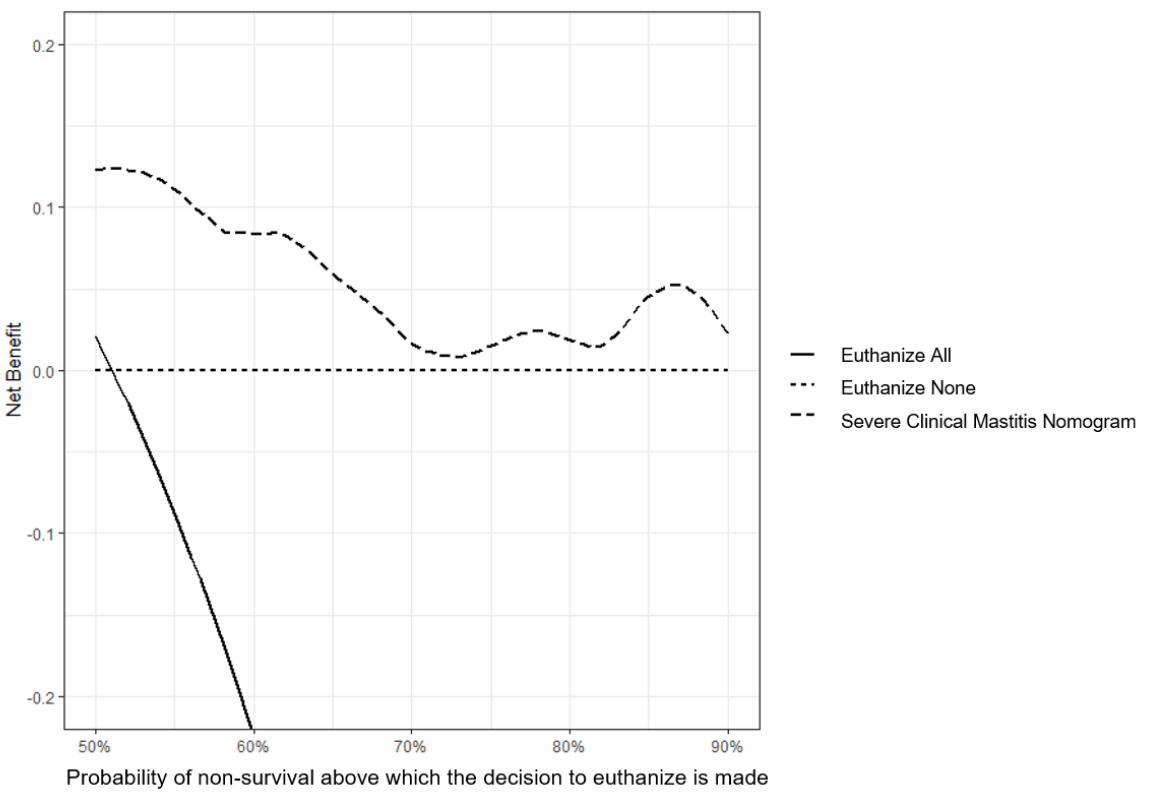
Figure 3. Decision analysis curve at day 60 of a nomogram predicting survival of dairy cows coming from 124 herds in Québec, Canada with severe clinical mastitis in the 60-day period following a veterinary clinical evaluation.